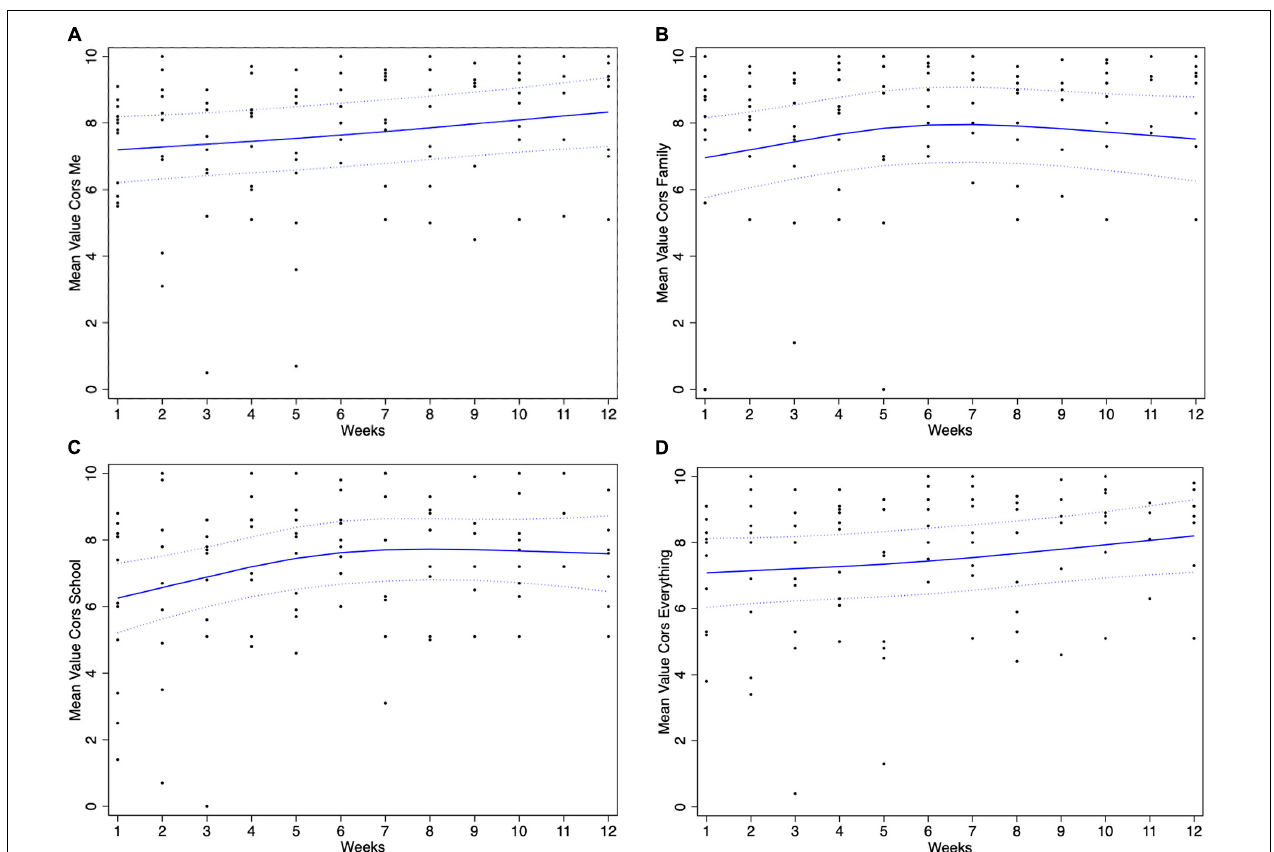
FIGURE 1 | Mean Changes in Child Outcome Rating Scale (CORS) scores in TARA participants based on linear mixed models with restricted cubic splines—dashed linear are estimates plus or minus one standard error. The changes are presented for the four items of CORS self-assessed by the participants and describing (A) themselves (How am I doing?), (B) family (How are things in my family?), (C) school (How are things at school?), and (D) their general sense of wellbeing/distress (How is everything